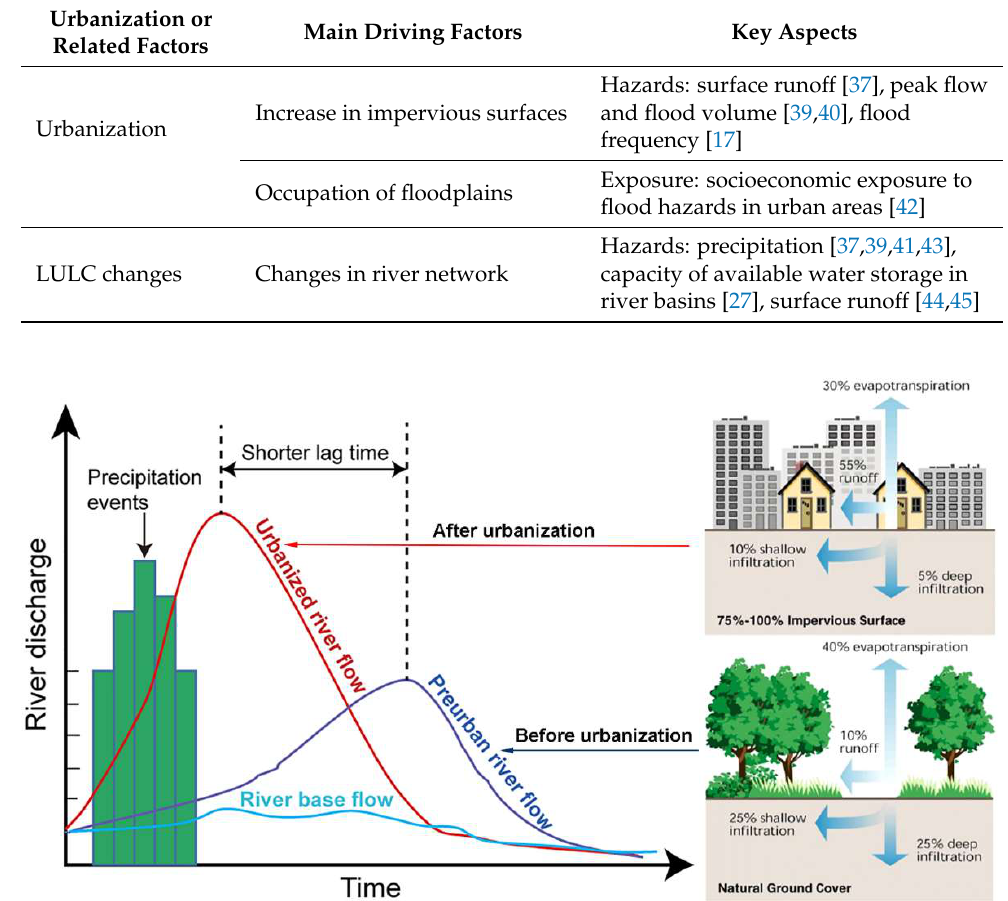
Figure 3. Impacts of urbanization on surface runoff, peak flow and flood volume (lag time represents lag time between storm peak and river discharge peak) (adapted from [37,39]).